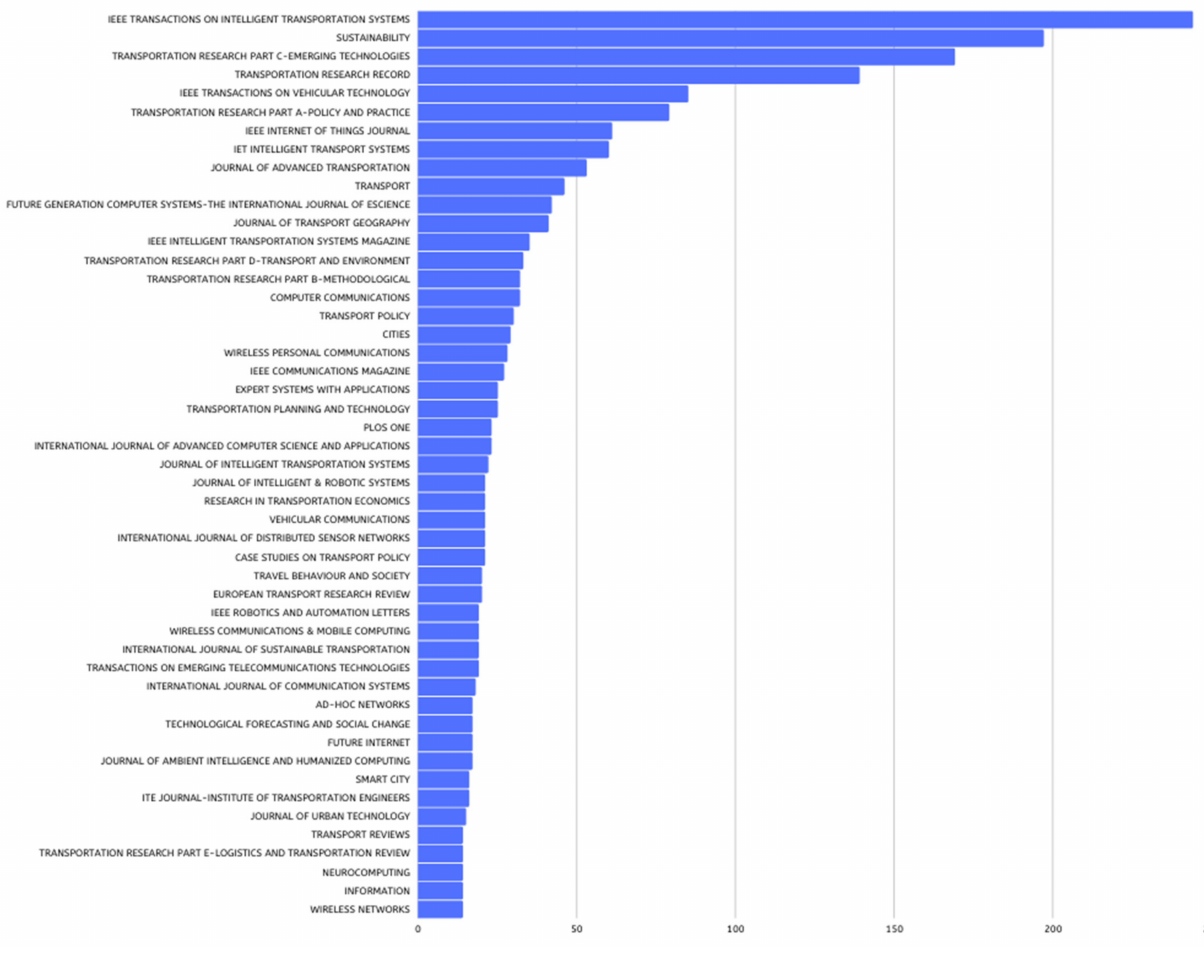
Figure 3. Top 50 journals with published works on ‘Smart Urban Mobility’, with the x-axis represent- ing the number of publications. Illustration by